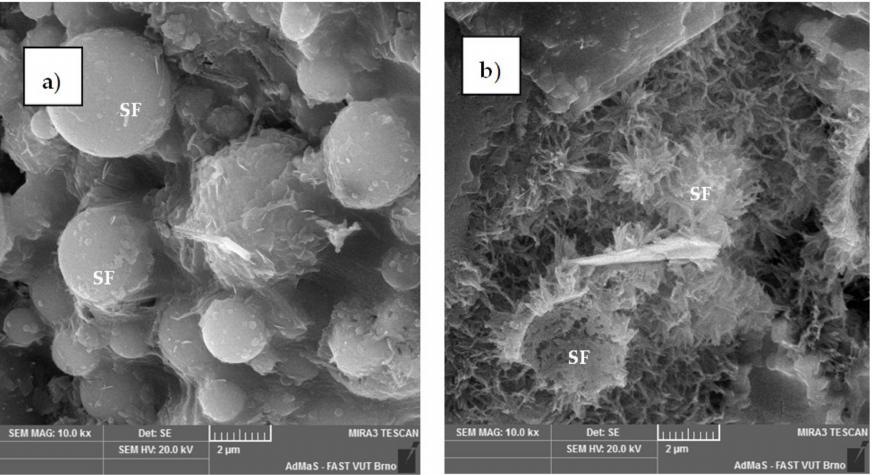
Figure 11. Morphology of cement hydration products modified by silica fume at age of 28